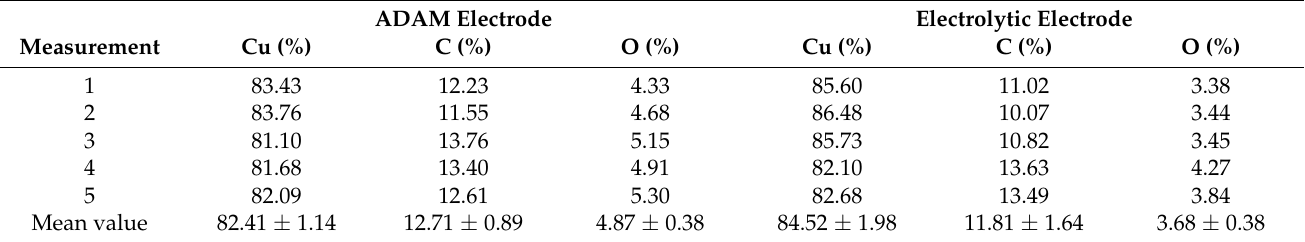
Figure 8. Spectrum of elements on the surface of the ADAM electrode. Table 8. Quantification of elements on the surface of both electrodes.